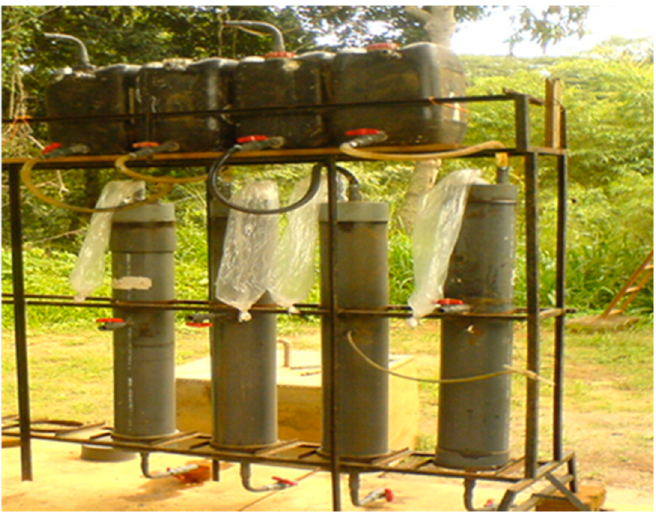
Figure 7. Setup of leaching columns .